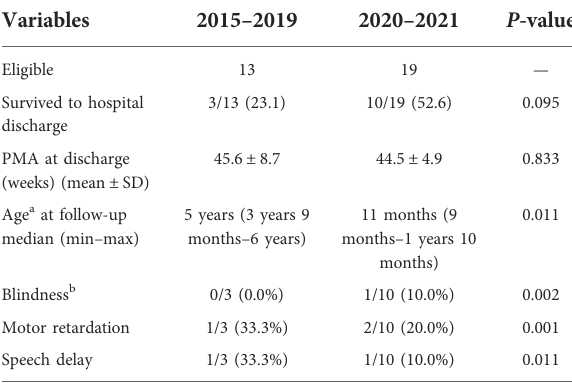
TABLE 4 Comparison of survival and neurodevelopmental outcomes during 2015 – 2019 and 2020 –